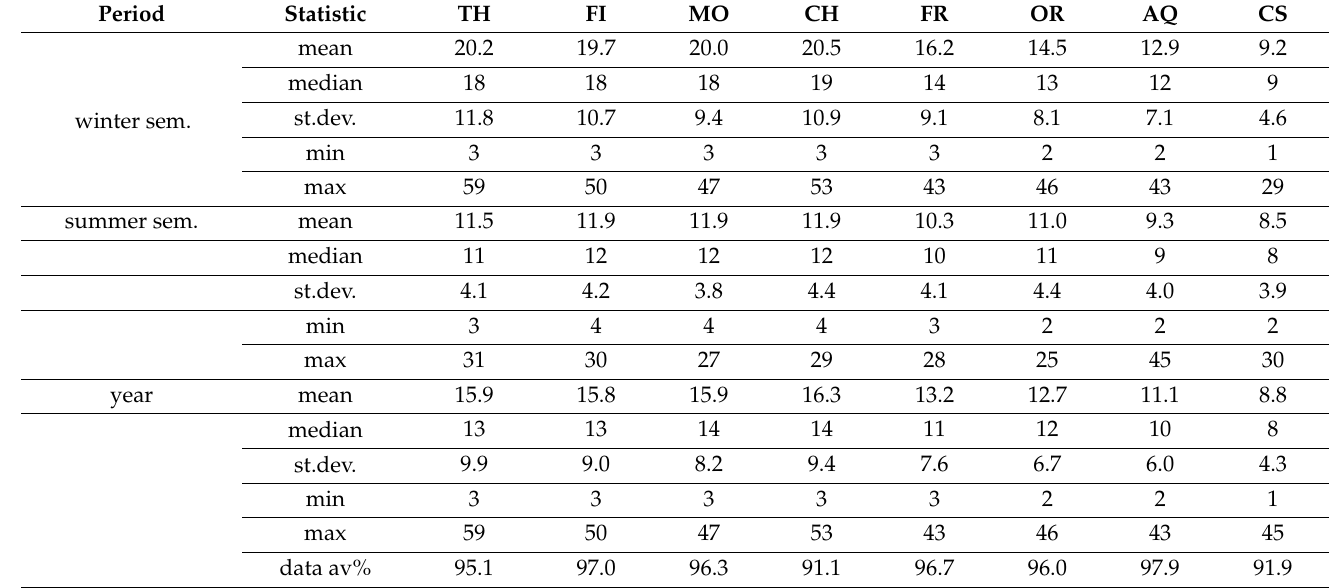
Table 2. Summary statistics for PM2.5 (expressed in µ g · m − 3 ) measured in the eight stations of the network in the two-year period 2017–2018, for summer semesters (from April to September), winter semester (from October to March), and for the whole year.